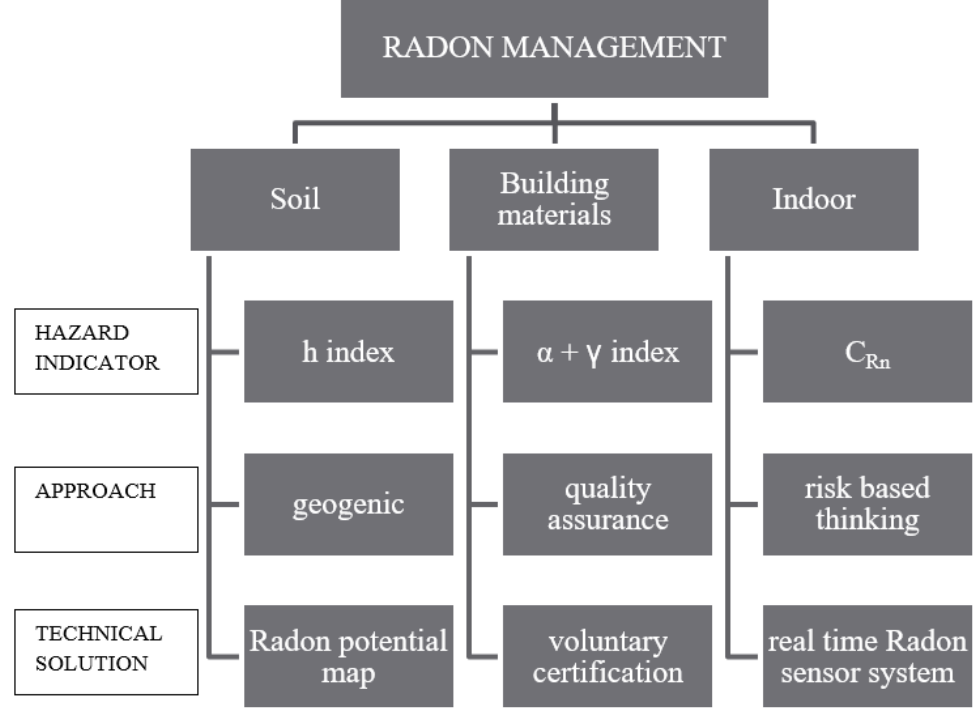
Figure 5. Logic scheme of the proposed strategy.